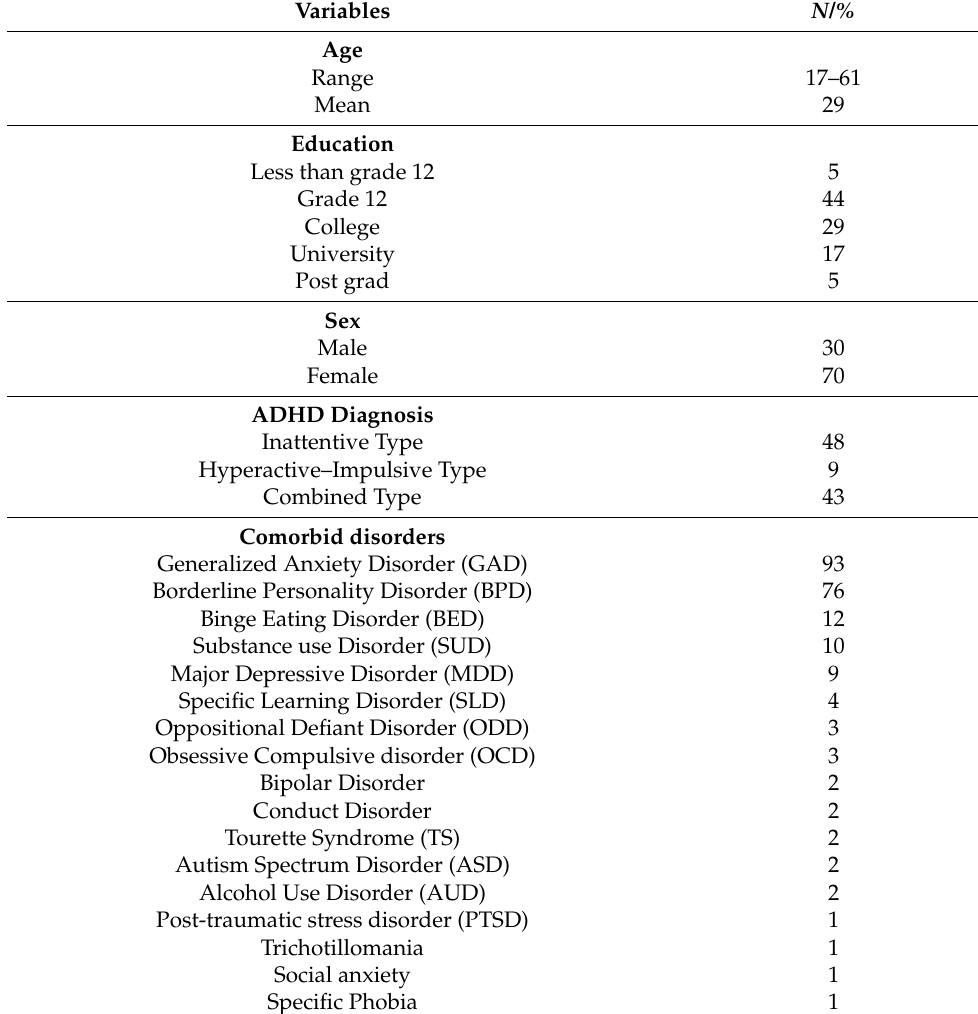
Table 1. Characteristics of Study Sample ( N = 100).